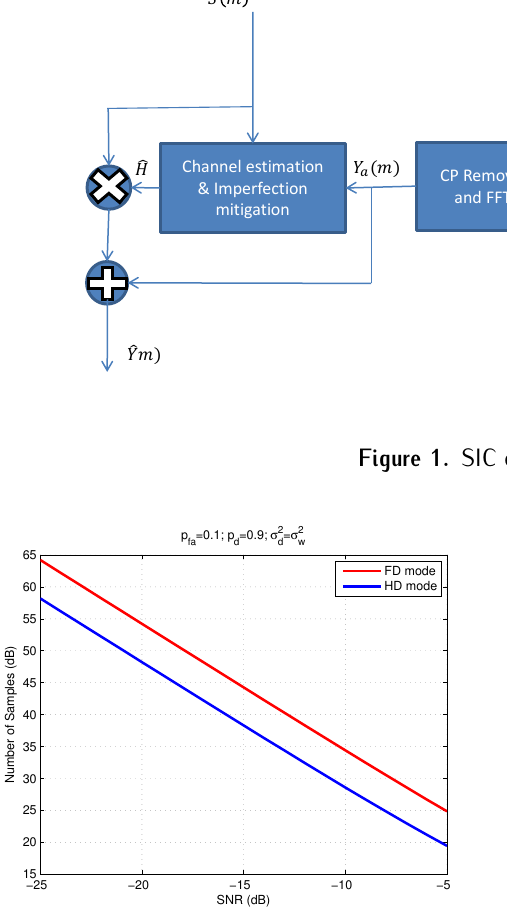
Figure 2. The number of samples required to reach p and p f a = 0 .